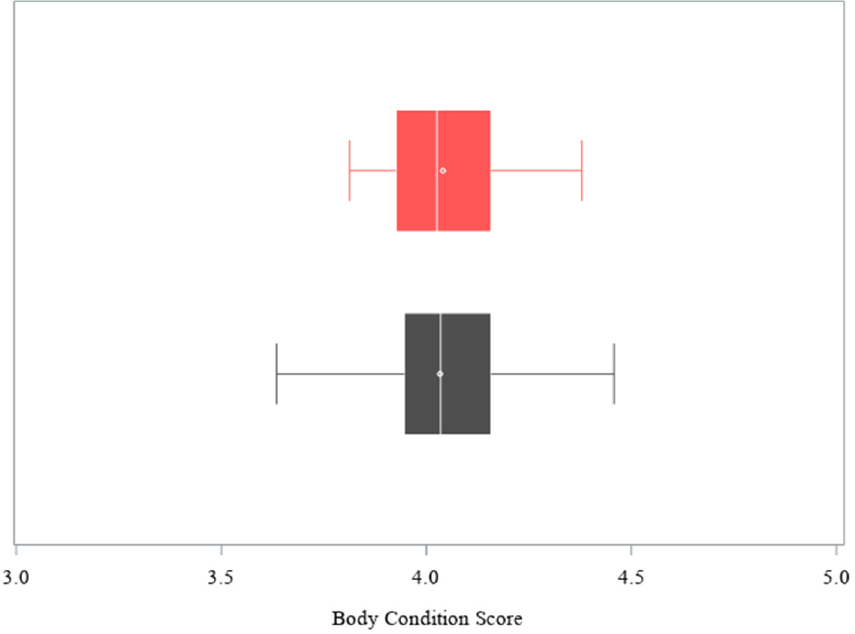
Figure 1. Distribution of least squares mean cow body condition score at rebreeding for each of the service sires (Angus, gray (cid:4) ; Hereford, red (cid:4) ). Each box represents the interquartile range (twenty-fifth to seventy-fifth percentiles), with the median value is indicated by a line and the mean value indicated by a marker ( ). Whiskers extend to the minimum and maximum (cid:51)